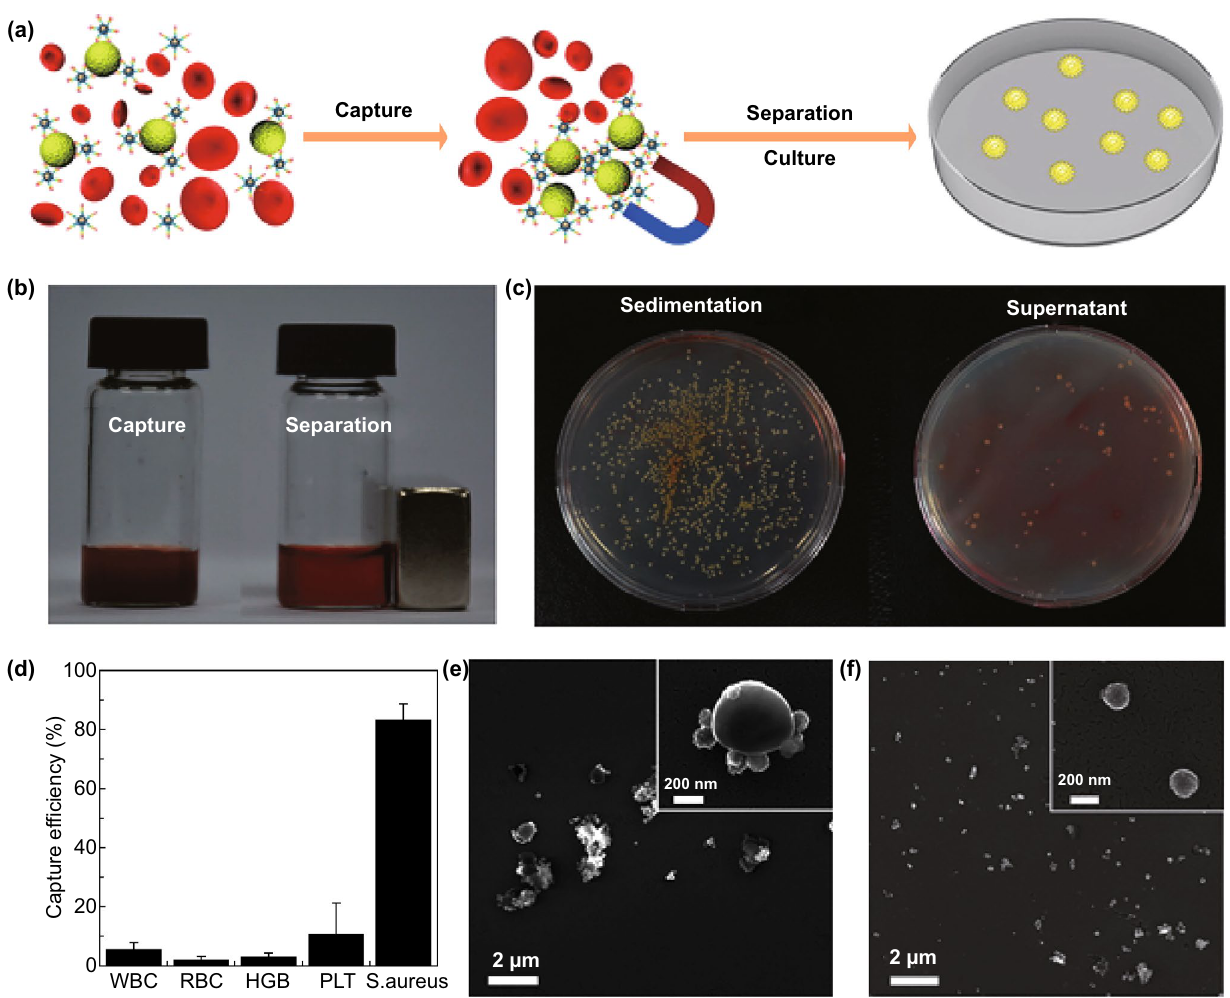
Fig. 9 a The illustration represents the strategy for the identification and capture of pathogenic bacteria ( S. aureus ). b The photograph exhibits the capture (left) and separation (right) of bacteria with Fe 3 O 4 /TiO 2 core–shell nanoparticles from an infected blood. c The number of colony‑ forming units in the re‑cultured S. aureus from sediment and supernatant in agar plates after the separation. d Capture efficiency of different compounds in blood after being treated with Apt S.aureus ‑Fe 3 O 4 @mTiO 2 . SEM images of the captured S. aureus (e) and non‑captured E. coli (f) with the aptamer decorated nanoparticles. Adapted from Ref. [28] with permission from the American Chemical